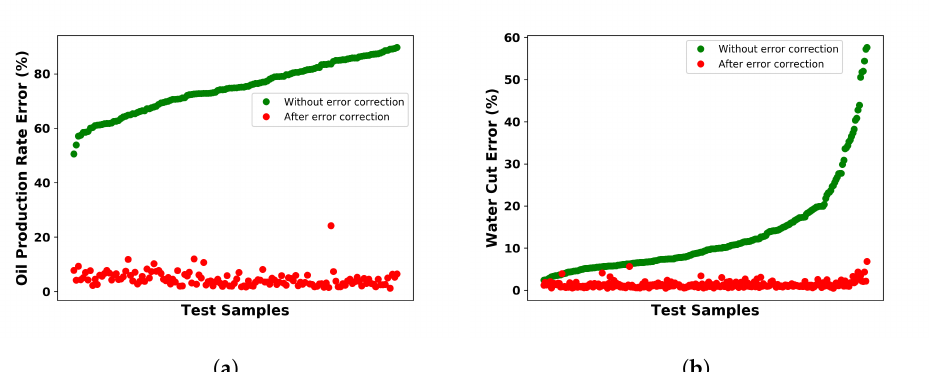
Figure 28. ( a ) Test case with producer well location at (11,10). ( b ) Comparison of oil production rate and ( c ) comparison of water cut, predicted the using global PMOR method alone using 50 samples (dotted green line) and after the implementation of error correction model (red circled line) with the true solution (blue line).